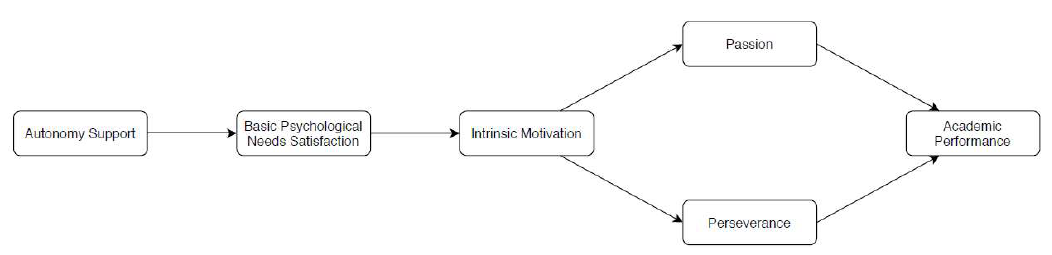
Figure 1. Hypothetical Model.